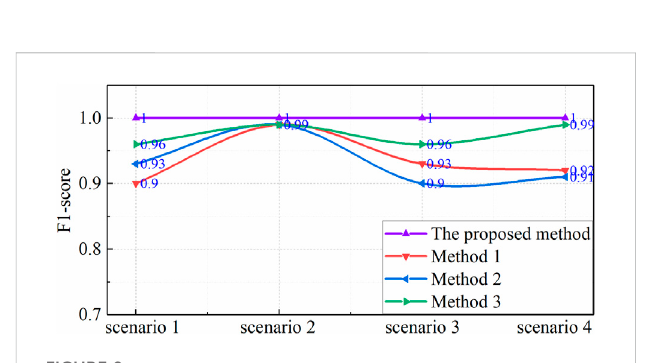
FIGURE 9 F-measure of four islanding detection methods in four.